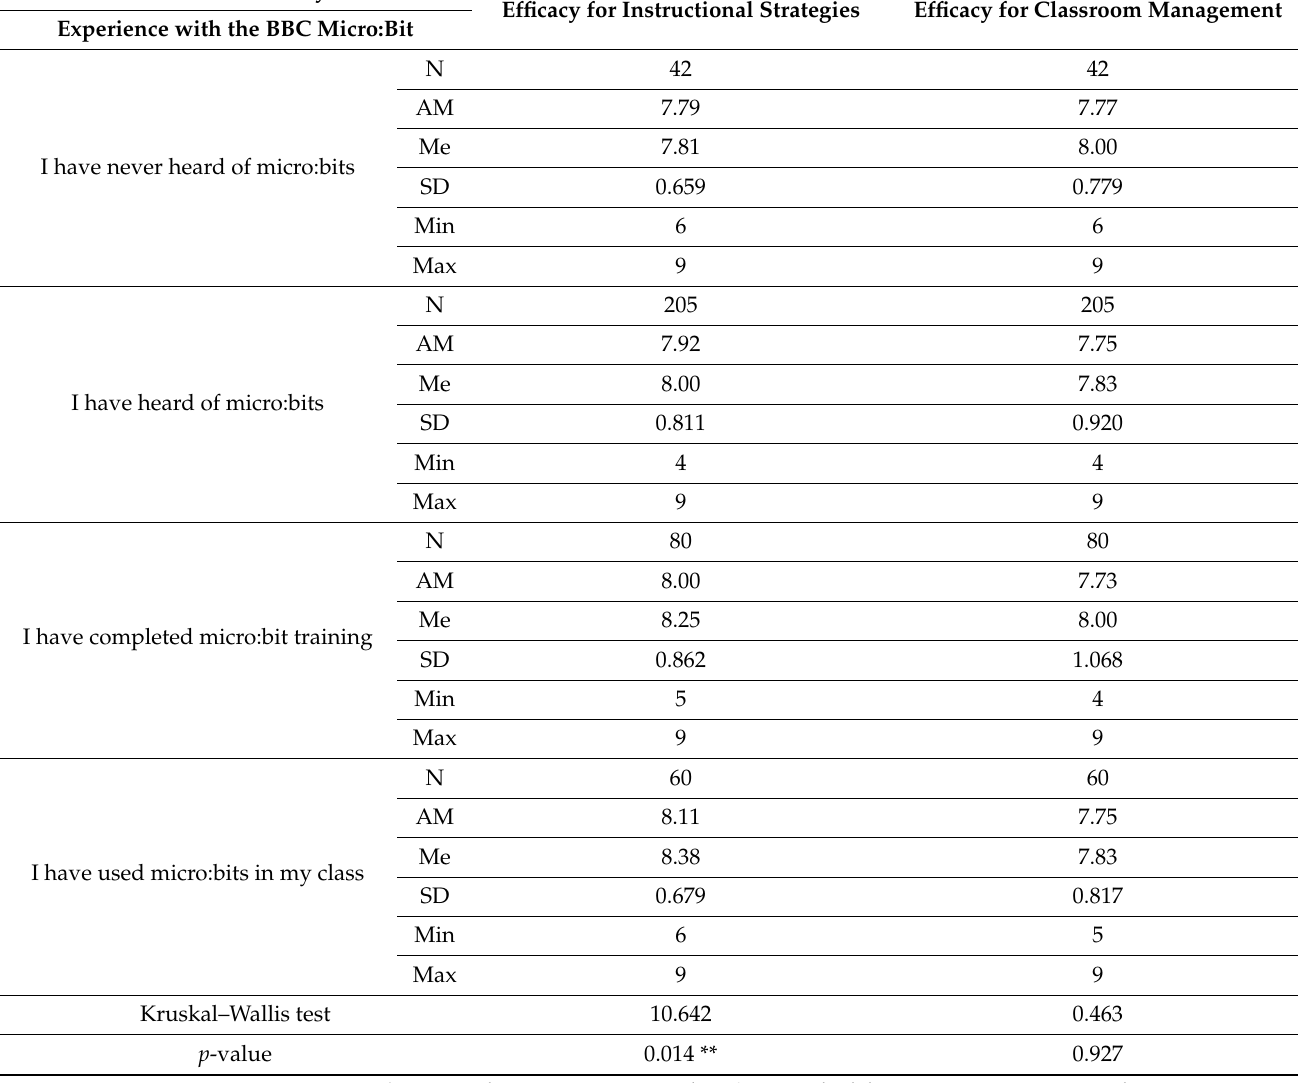
Table 5. T1 perceived efficacy of CS teachers based on experience with the BBC micro:bit. Perceived Efficacy Efficacy for Instructional Strategies Efficacy for Classroom Management Experience with the BBC